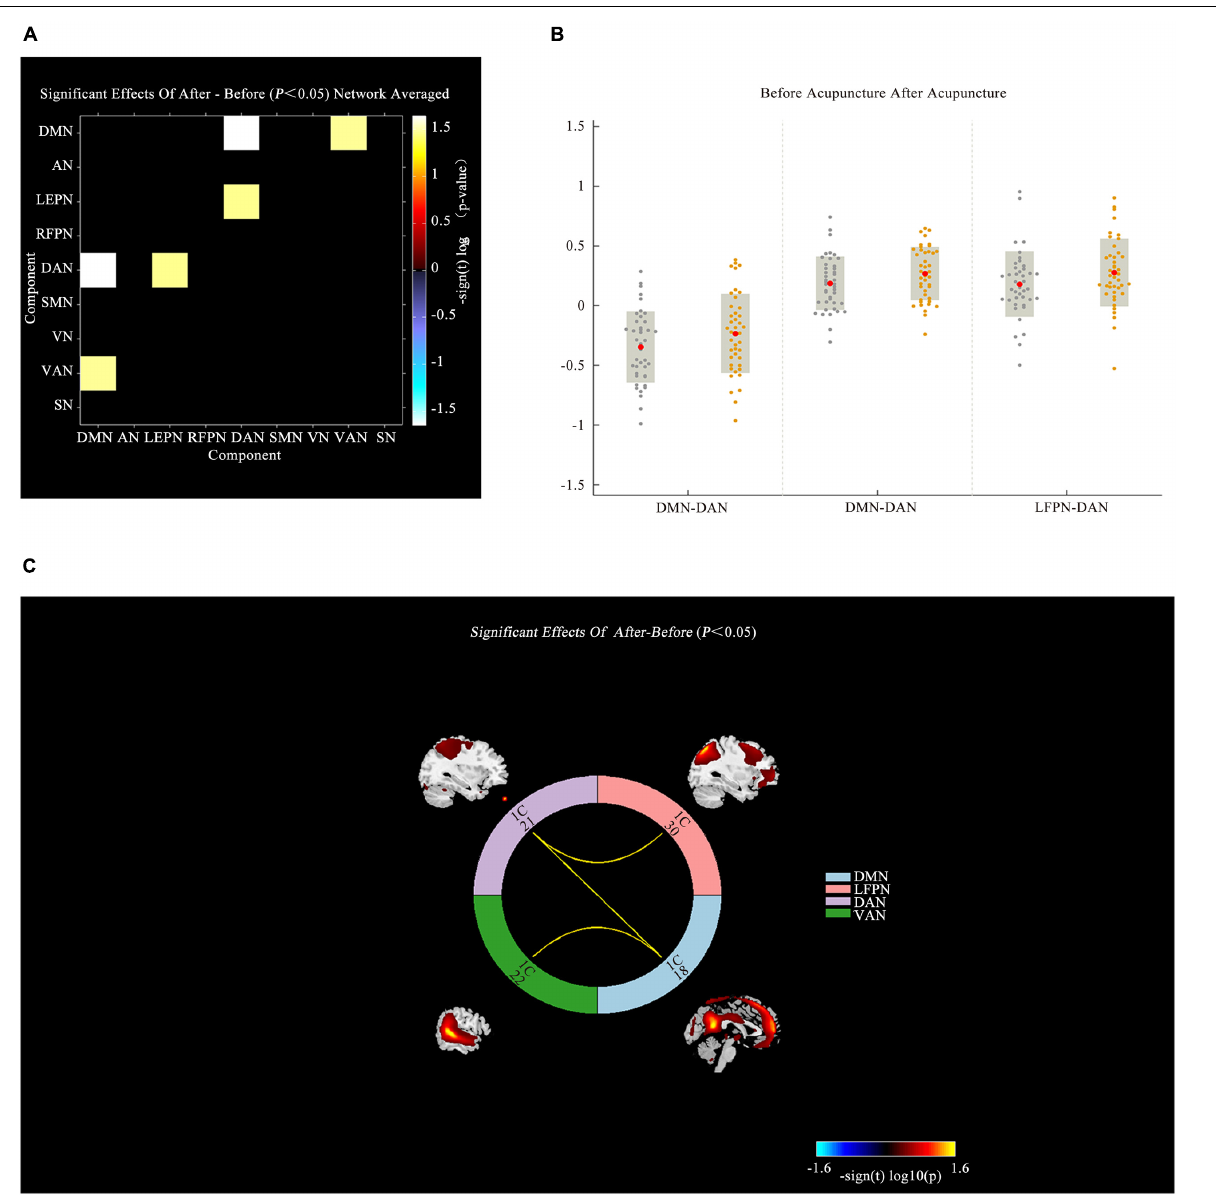
temporal gyrus is occulted into the lateral fissure and it is terms as transverse temporal gyrus. Therefore, we inferred that the altered brain activity of the core AN local that Heschl’s Gyrus may be related to affective in IBS. Ma et al. reported that ALFF values were decreased in the right superior temporal gyrus of patients with IBS (Ma et al., 2015). Compared with HCs, the functional connectivity between the left hippocampus and left